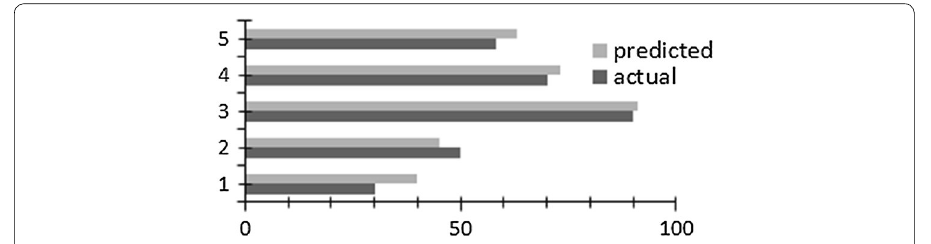
Fig. 2 Actual values of risk compared to predicted